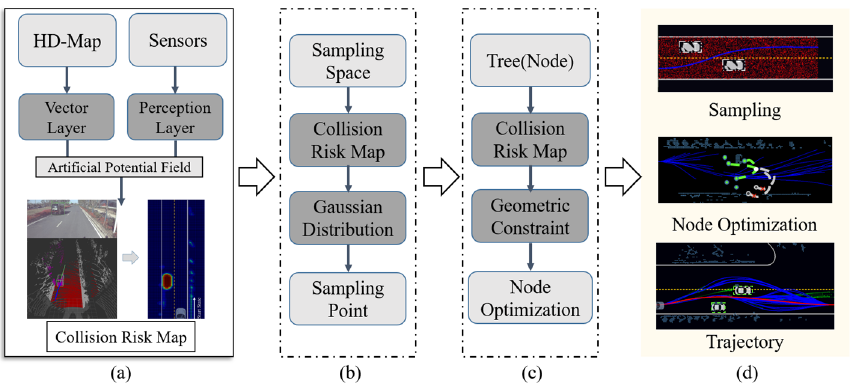
Figure 2. Overall architecture of the algorithm(a-d).